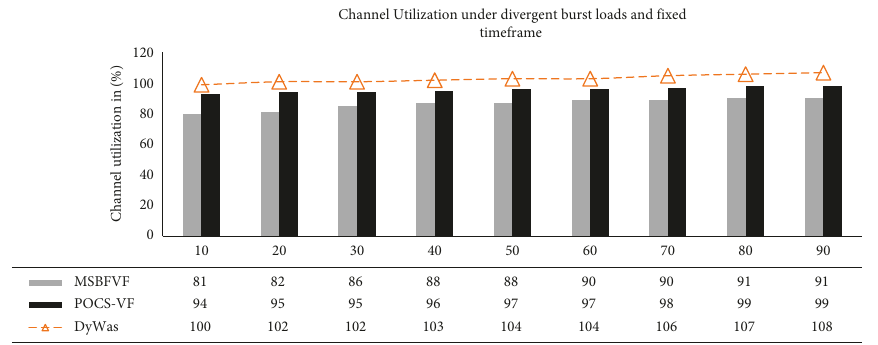
Figure 3: The ratio of channel utilization when a constant timeframe of 35 μ s and a varied burst load are